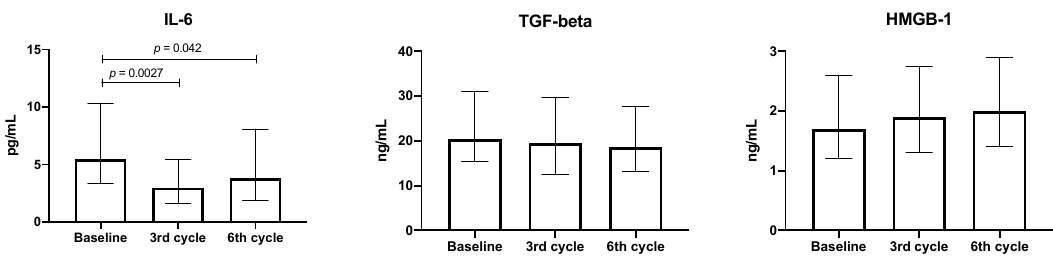
Figure 2. Concentration of plasma IL-6, TGF- β , and HMGB-1 throughout treatment, n = 53. Median and interquartile ranges are shown.